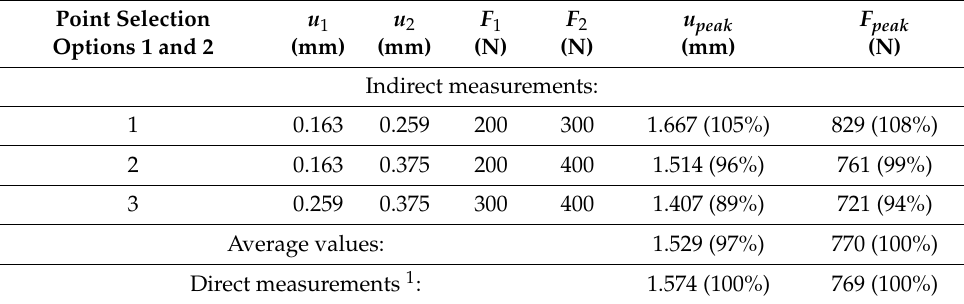
Table 1. Initial data ( u 1 , u 2 , F 1 and F 2 ) and the calculation results ( u peak and F peak